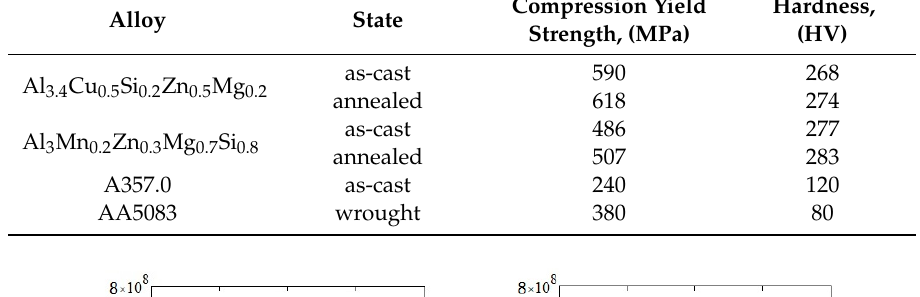
Table 7. Alloys chemical composition in weight percent